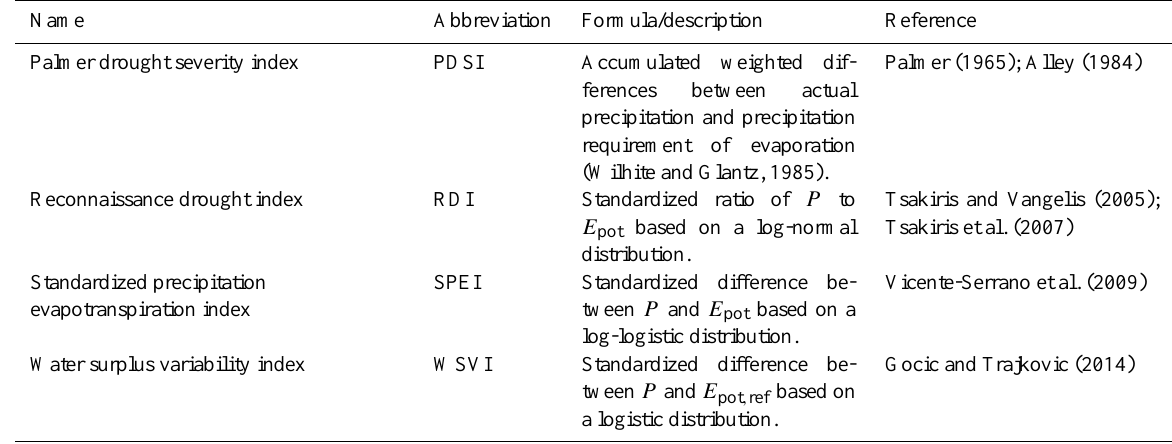
Table B2. Meteorological drought indicators based on precipitation and a measure of potential evaporation.